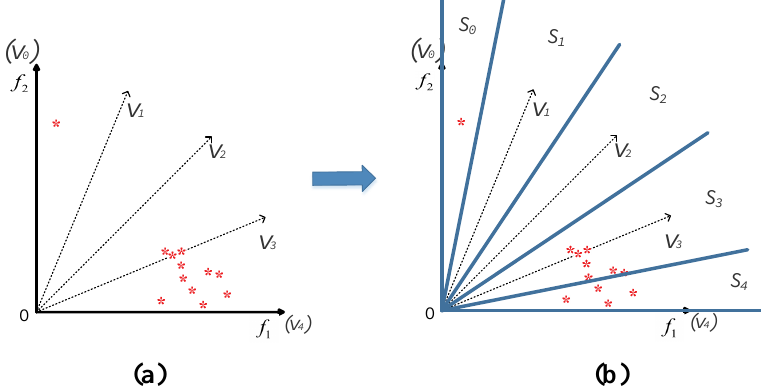
Figure 3. Example showing the definition of subspaces and reference vectors. ( a ) Distribution of predefined reference vectors and candidate solutions where the red asterisks denote candidate solutions. ( b ) Subspaces generated by the reference